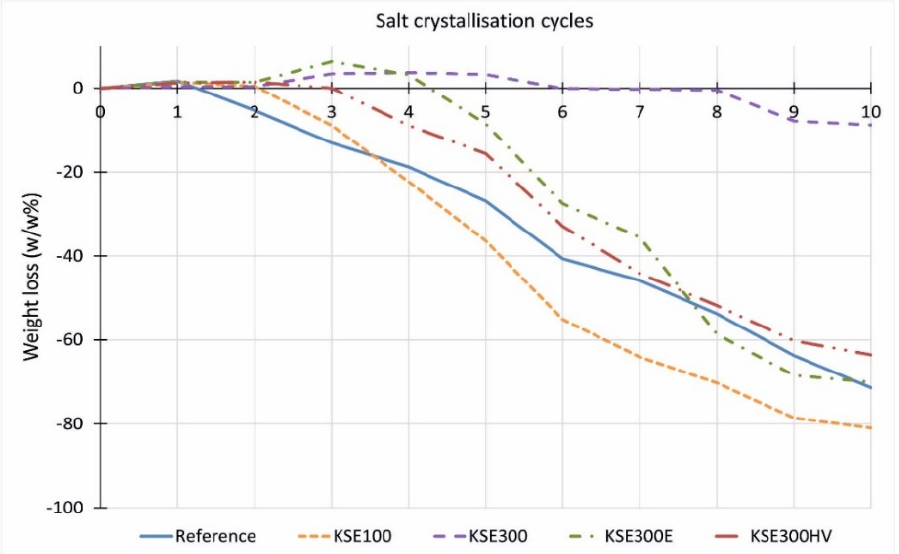
Figure 16. Weight loss of untreated and treated medium-grained porous limestone from Sóskút (SM) after salt crystallization cycles.